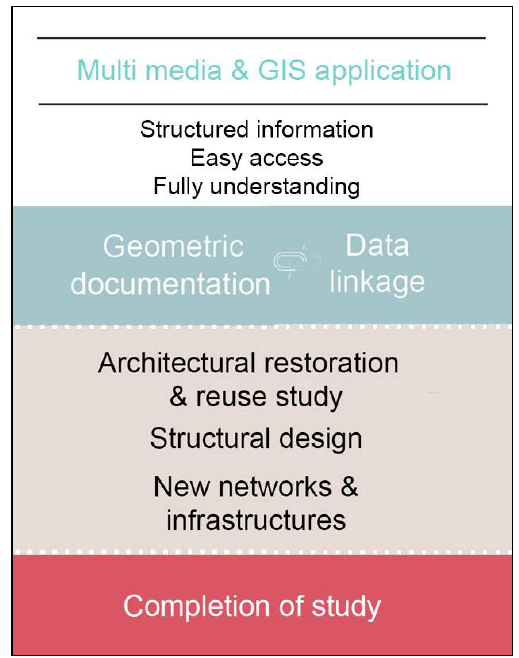
Figure 20 . Workflow of the completion of a restoration